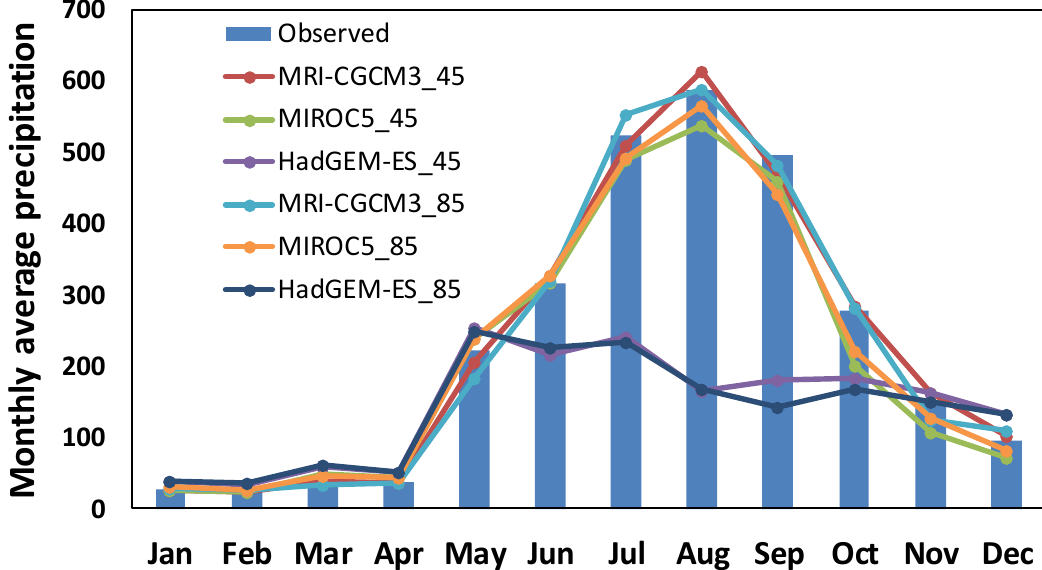
Figure 5. Comparison between observed and downscaled Global Climate Models (GCMs) output for monthly average rainfall. Here three GCMs used are MRI-CGCM, MIROC5 and HadGEM-ES. Suffix 45 and 85 represents RCP 4.5 and 8.5 used here.